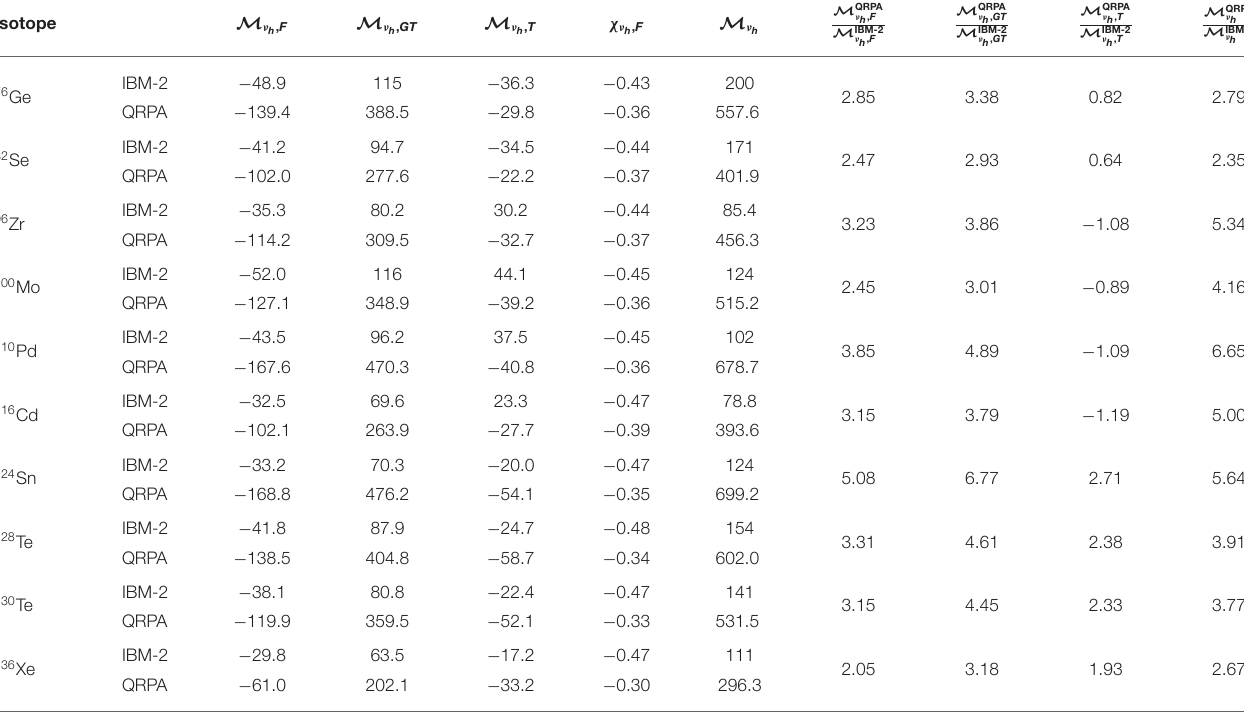
TABLE 5 | Comparison between interacting boson model (IBM-2) and quasiparticle random phase approximation (QRPA) heavy neutrino exchange Fermi (F), Gamow–Teller (GT), tensor (T), and full M ν nuclear matrix elements (NMEs) as defined in Equations (12) and (13) and calculated using quenched value g A = h